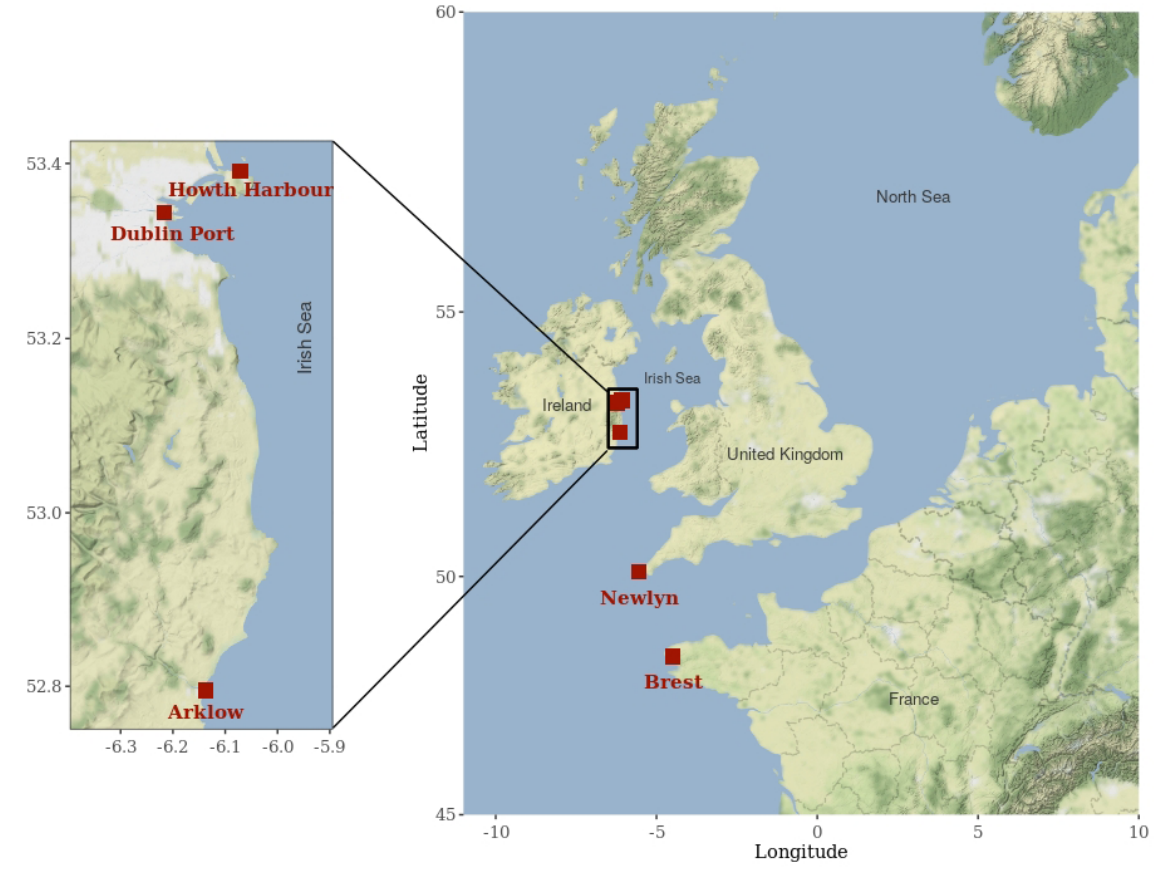
Figure 2. Locations referred to in this study: Dublin Port, Howth Harbour, Arklow, Brest and Newlyn. Table 3. Differences between rates of SLR in MLW, MSL and MHW for Dublin Port and those for Arklow or Howth Harbour. Large values with small standard errors indicate a significantly higher rate at Dublin